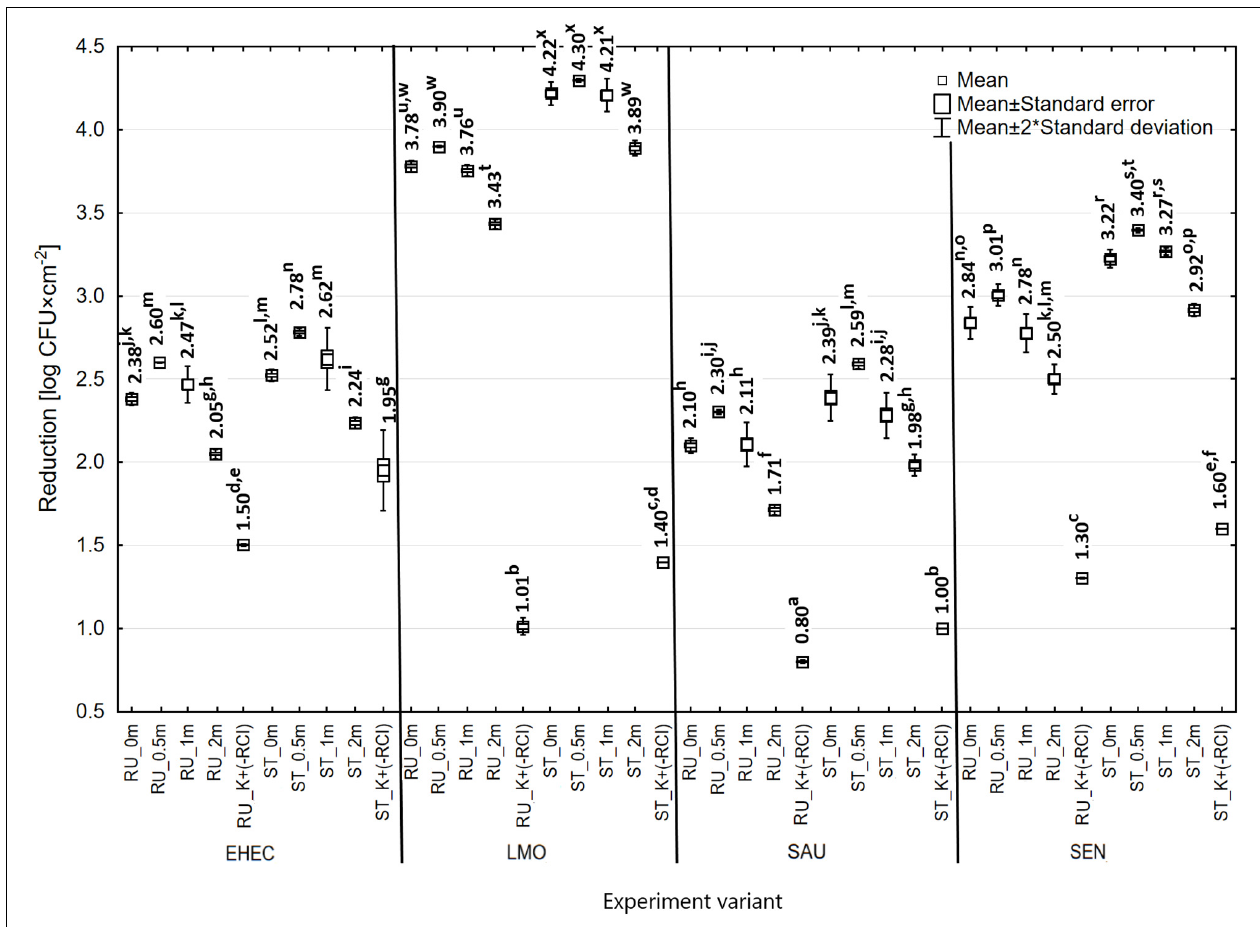
FIGURE 8 | Reduction in the number of bacteria under the influence of RCI depending on the distance from device [RU – rubber, ST – stainless steel; a, b, c – values marked with different letters are significantly different ( P < 0.05); EHEC – E. coli O157:H7; LMO – L. monocytogenes ; SAU – S. aureus ; SEN – S .